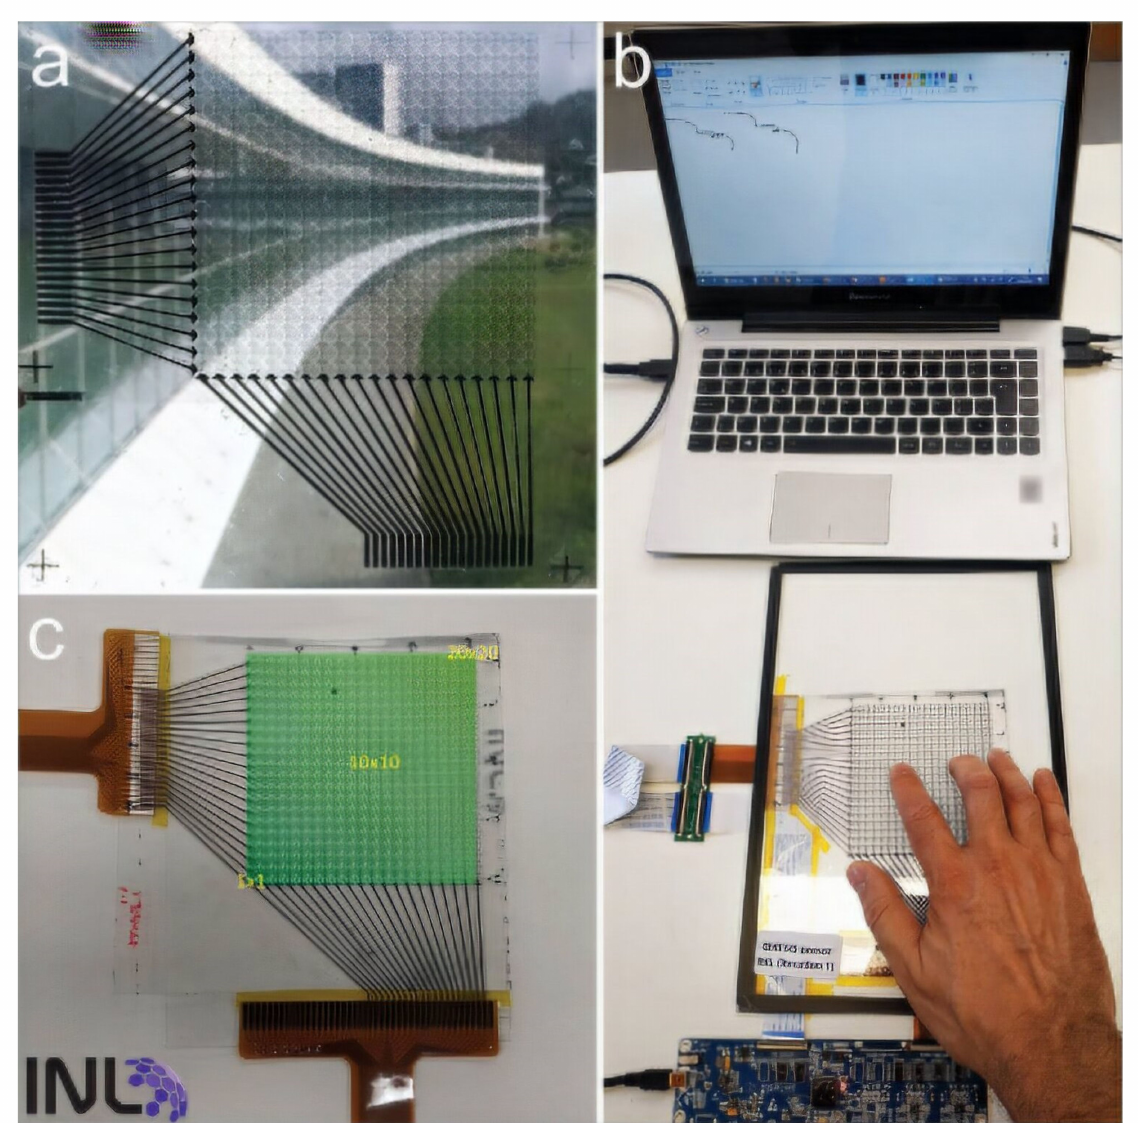
Figure 9. Graphene-based touch sensor prototype. ( a ) Overlapped top and bottom PET panels with the spray-coated graphene row (Tx) and column (Rx) electrodes and conductive Ag pads. ( b ) Complete system (touch sensor + controller + computer) operated in multi-touch mode. ( c ) Complete touch sensor interfaced with external connections. (Reproduced with permission from ref